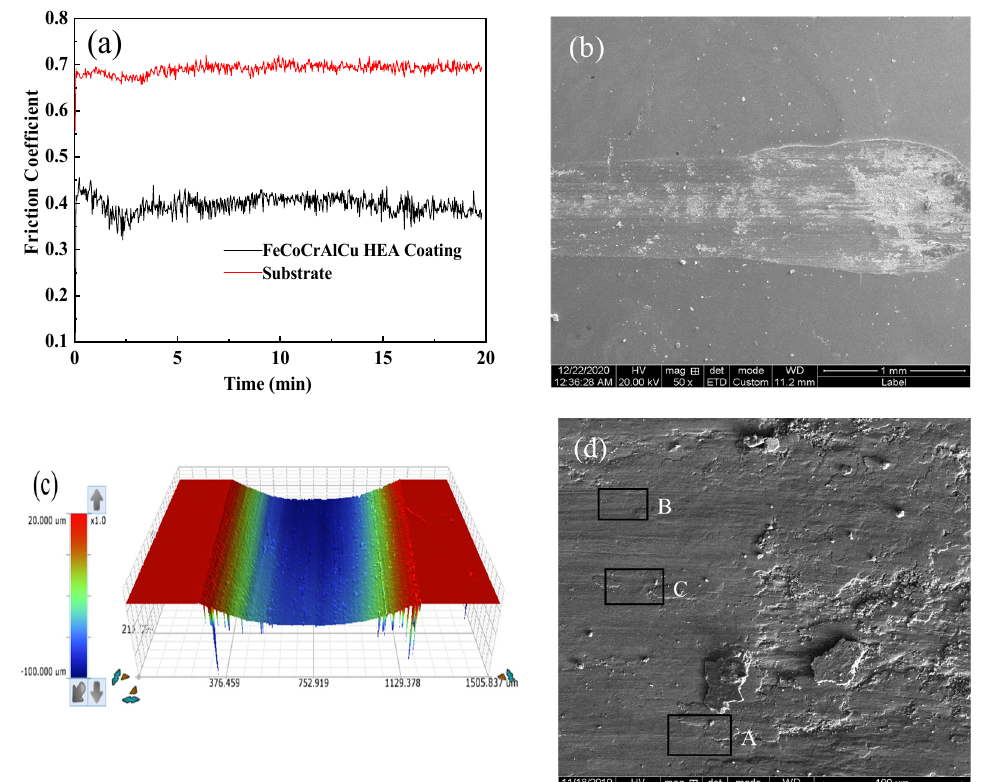
Figure 7. Friction test results for the FeCoCrAlCu HEA coating: ( a ) friction coefficient curve, ( b ) friction and ( c ) wear of FeCoCrAlCu HEA coating and the corresponding 3D morphology, and ( d ) SEM image of the friction surface (area A: a large number of delaminations, area B: grooves, area C: furrows and abrasive particles).